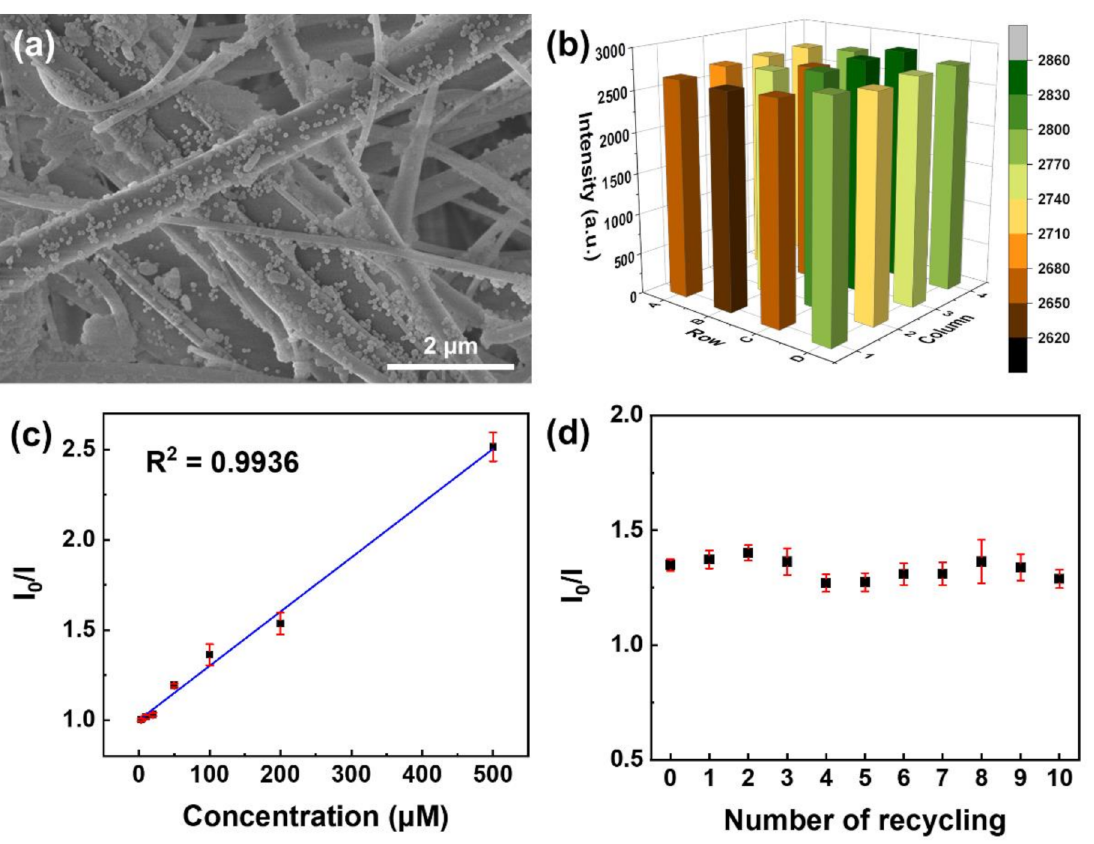
Figure 6. ( a ) SEM image of Eu-TCA/GMF. ( b ) Luminescence intensity of 4 × 4 wells of microplate containing the independently fabricated Eu-TCA/GMFs. ( c ) Stern–Volmer plot of the luminescence quenching of Eu-TCA/GMF ( n = 7) as a function of phosphate concentration. ( d ) The luminescence intensity of Eu-TCA/GMF ( n = 7) after ten runs of recycling. The concentration of phosphate is 100 µ